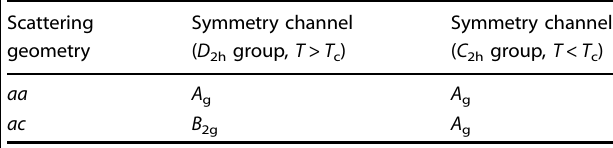
Table 1. The Raman selection rules in the